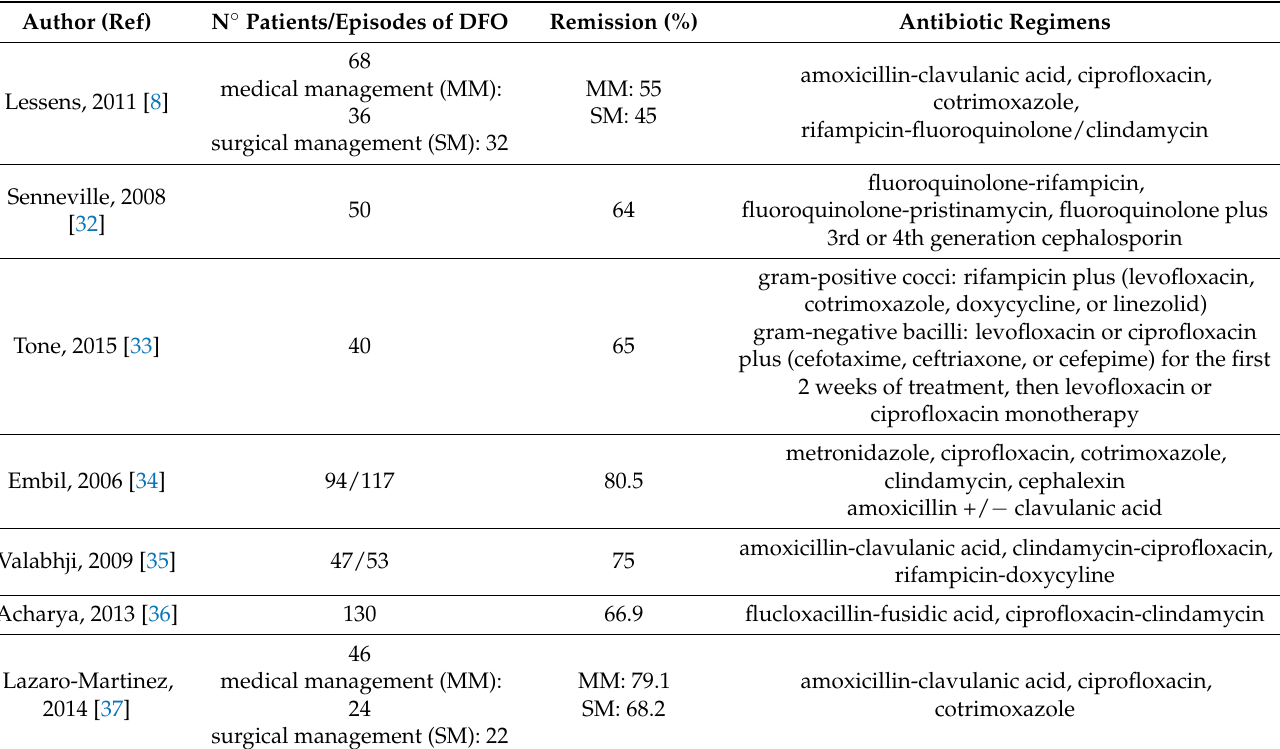
Table 2. Antibiotic regimens used in patients treated medically for diabetic foot